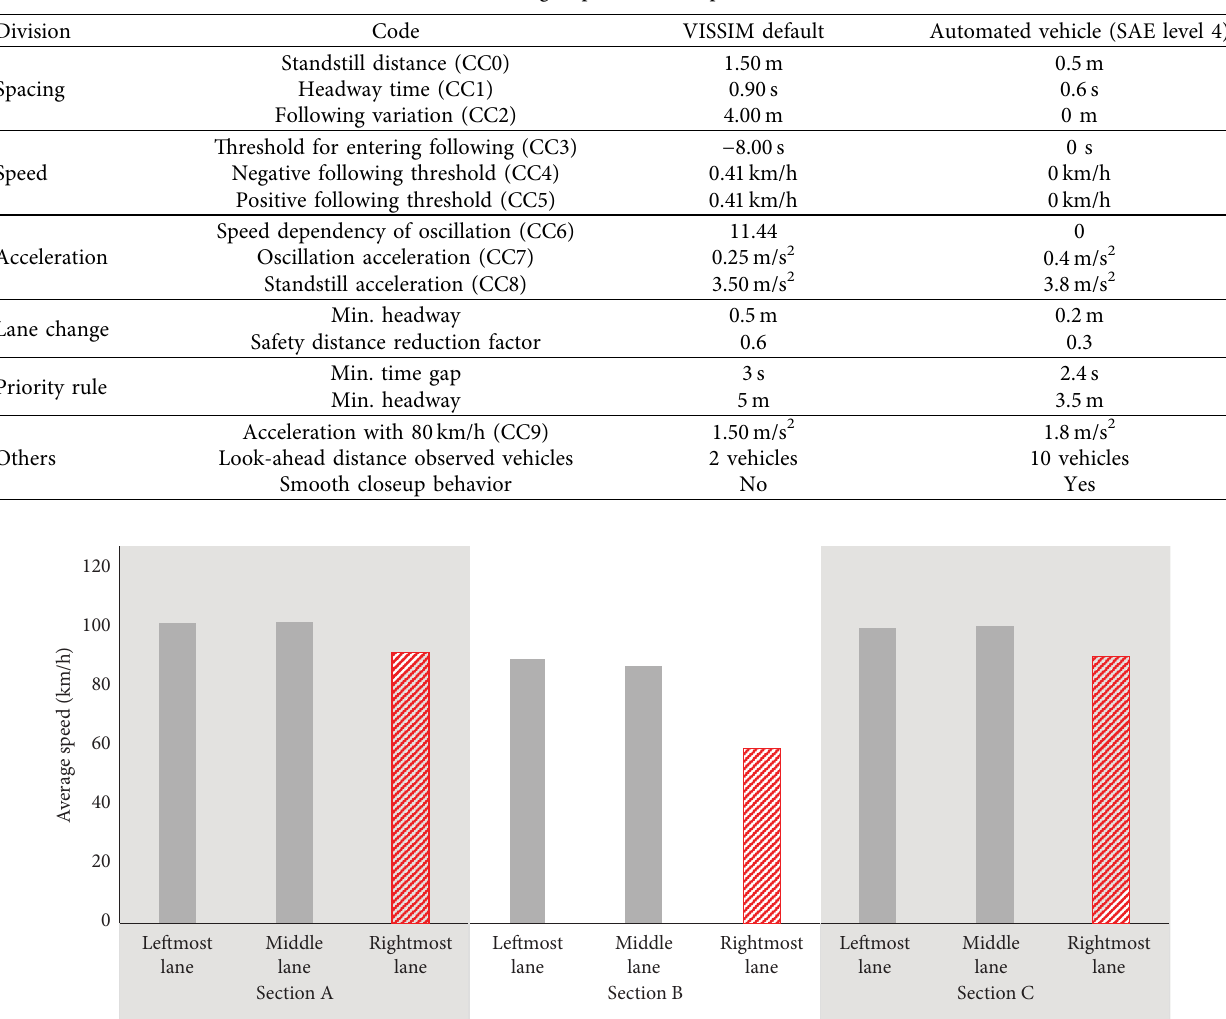
Figure 3: Comparison of speed by lanes for each section.